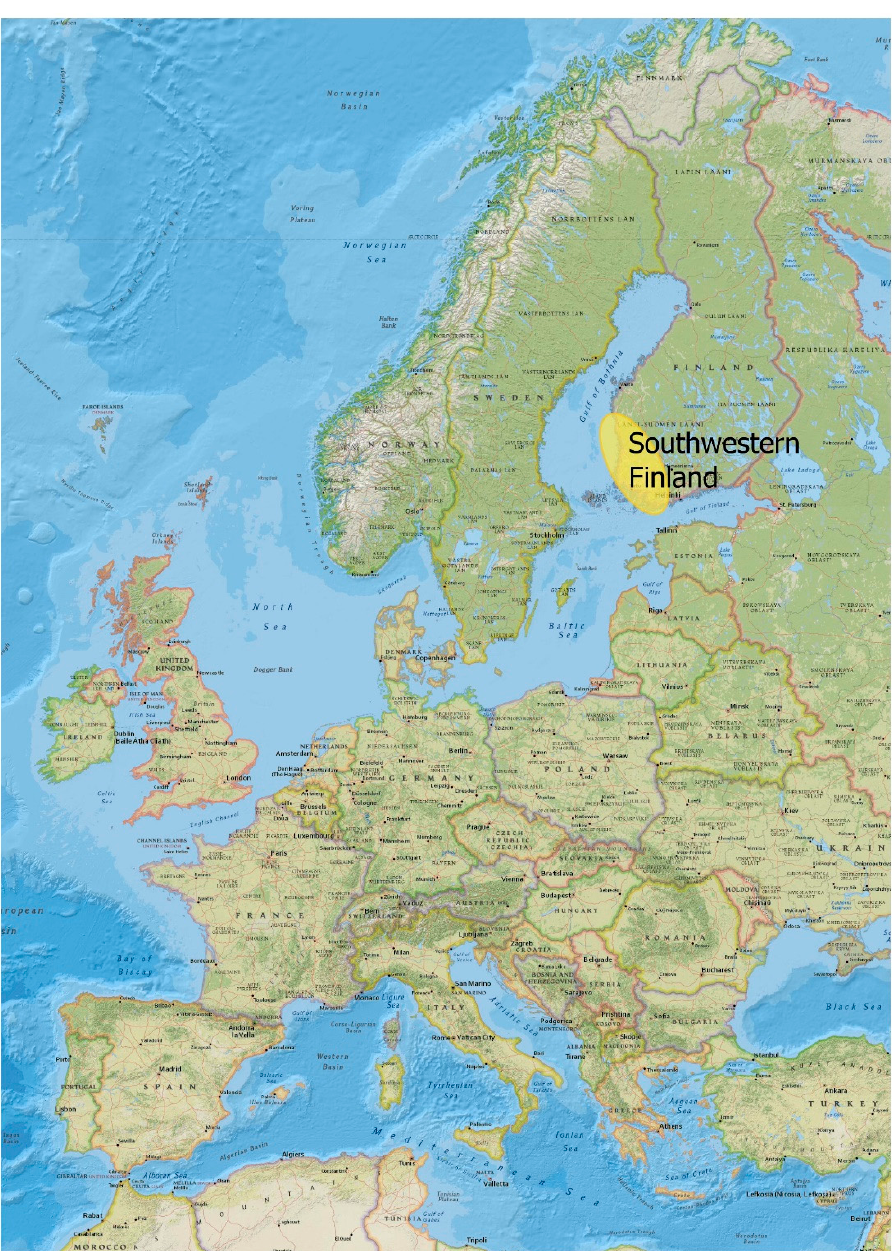
Figure 1. Southwestern Finland, highlighted in yellow. The central distribution area of Kiukainen culture extends from southern Ostrobothnia to the Gulf of Finland near the Helsinki region.